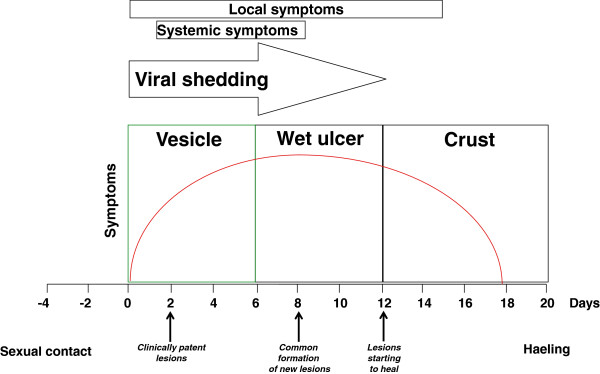
Clinical course of primary genital herpes.